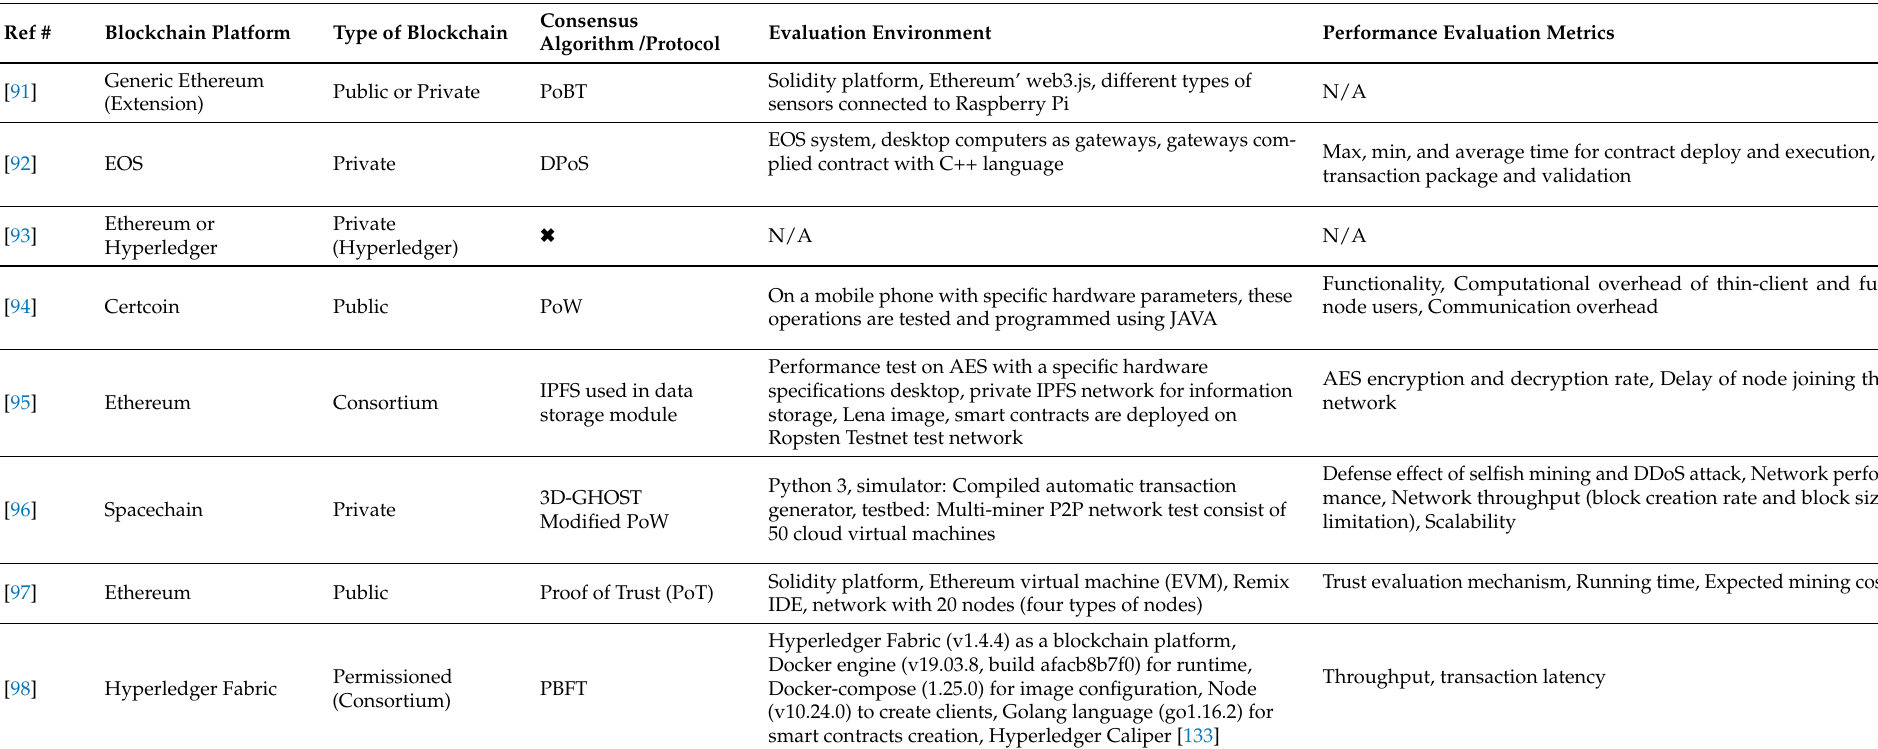
Table 3. Generic approaches articles: blockchain characteristics, evaluation environment, and metrics.